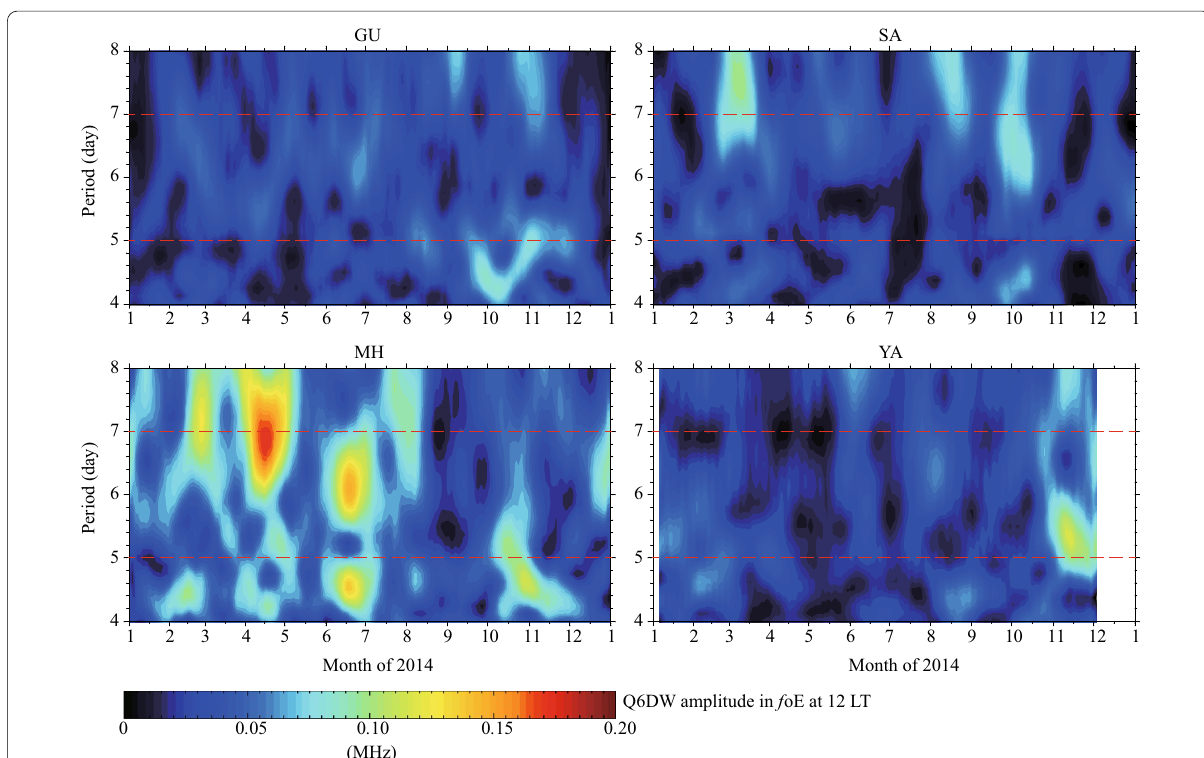
Fig. 4 The time variations of the f oE spectrum at 12:00 LT during 2014 at Guam (GU), Sanya (SA), Wuhan (WU), Beijing (BP), Mohe (MH) and